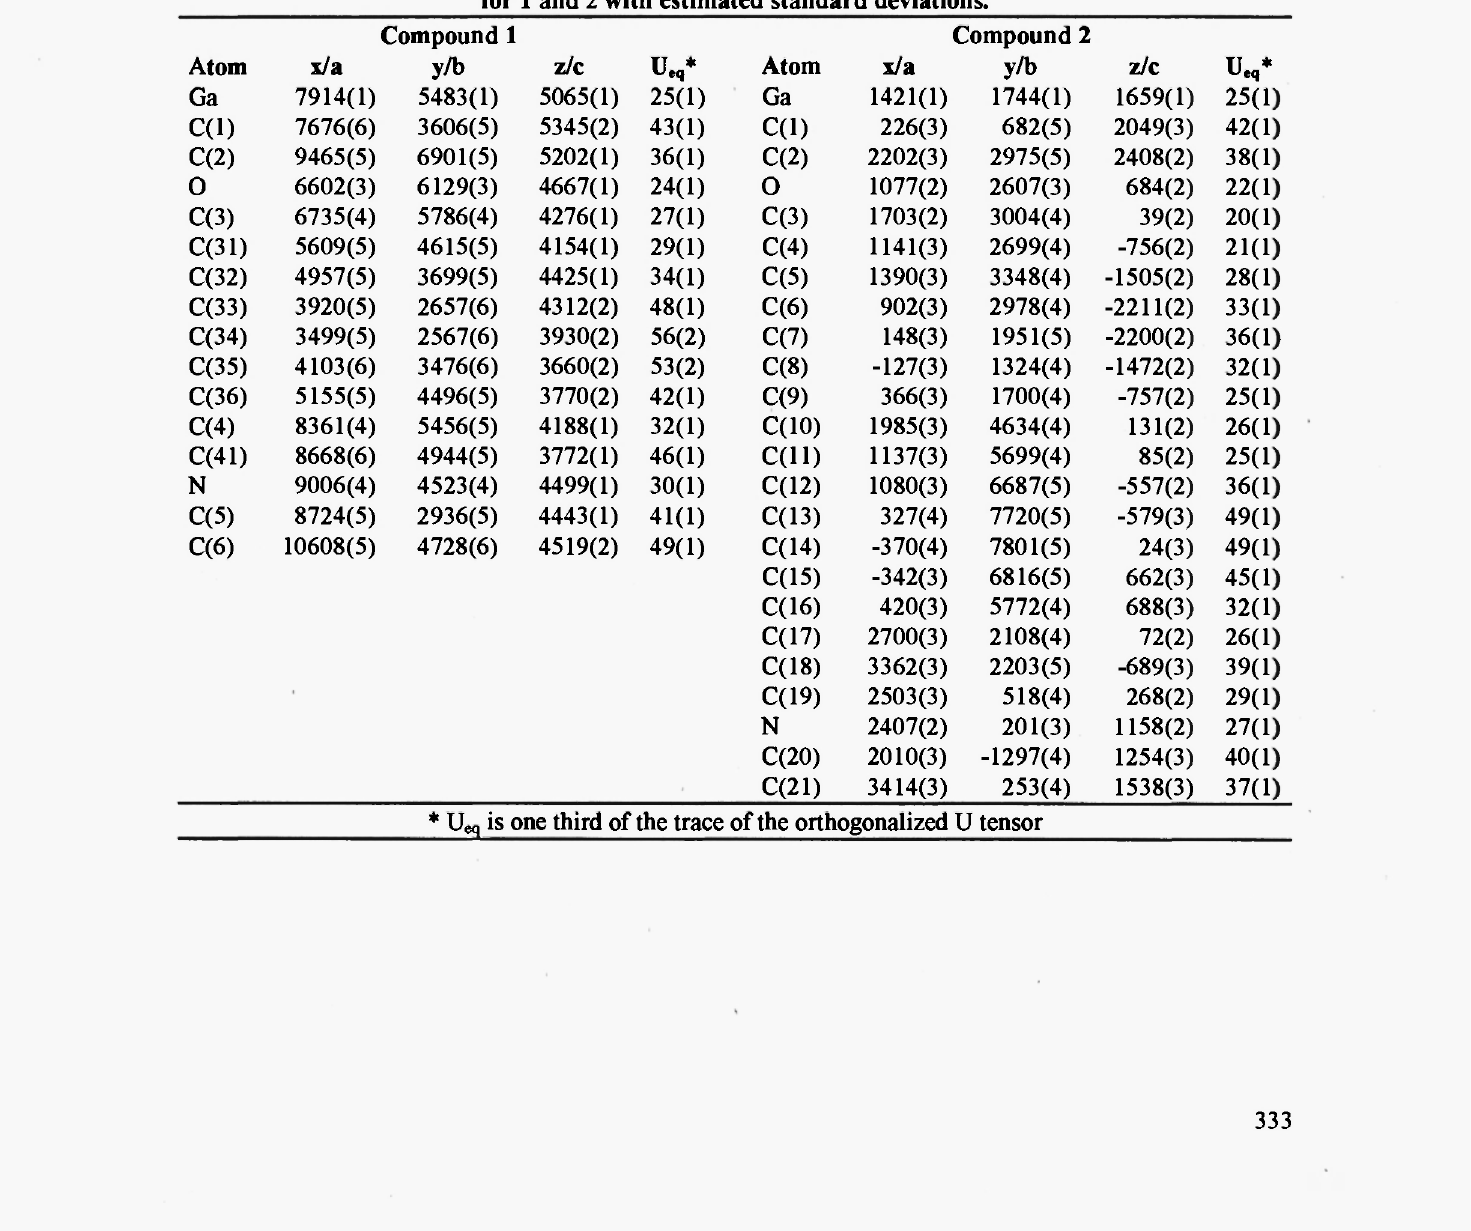
Table Π.: Atomic coordinates (χ 10 4 ) and equivalent isotropic displacement parameters (Ä 2 χ 10 3 ) for 1 and 2 with estimated standard